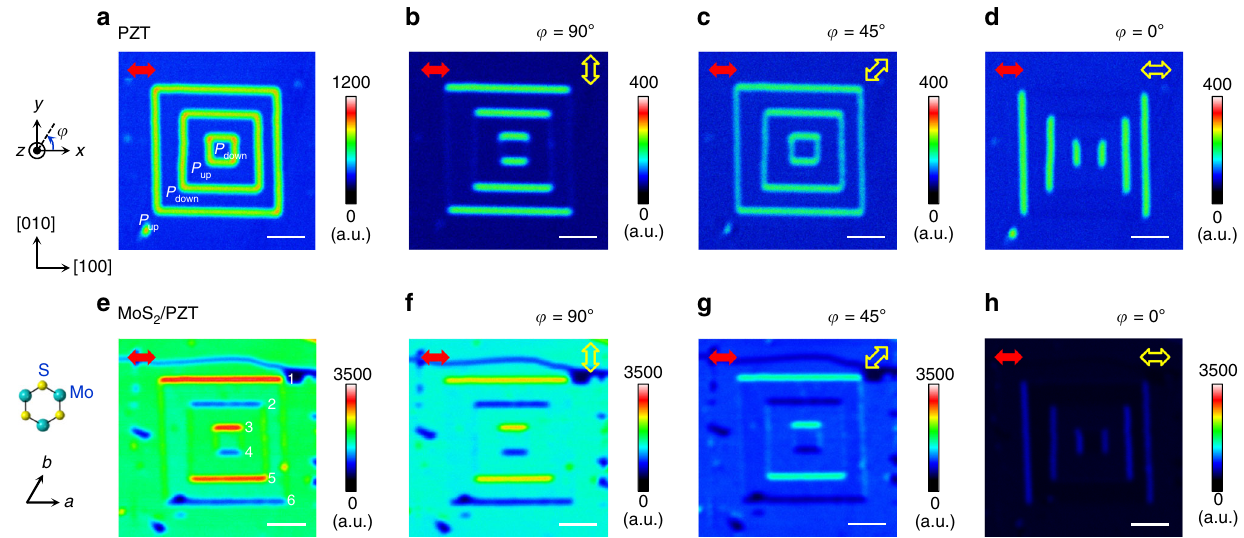
Fig. 2 Re fl ected SHG response of domains on PZT with and without MoS 2 top layer. a – d SHG mapping of the domain structure shown in Fig. 1c taken a with no analyzer applied and b – d with an analyzer applied at different angles φ (yellow open arrows) with respect to the incident light polarization (red solid arrows). The excitation laser power is 30 mW. e – h SHG mapping of the same domain structure with a 1L MoS 2 fl ake transferred on top taken with the same polarizer and analyzer settings as in a – d , respectively. The excitation laser power is 20 mW. The scale bars are 3 μ m. The crystalline orientations of PZT and MoS 2 are shown as